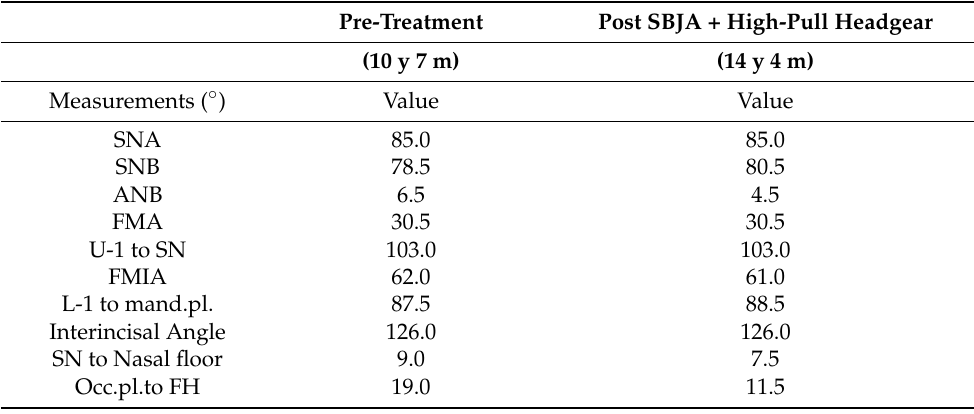
Table 1. Cephalogram angle measurements of Case